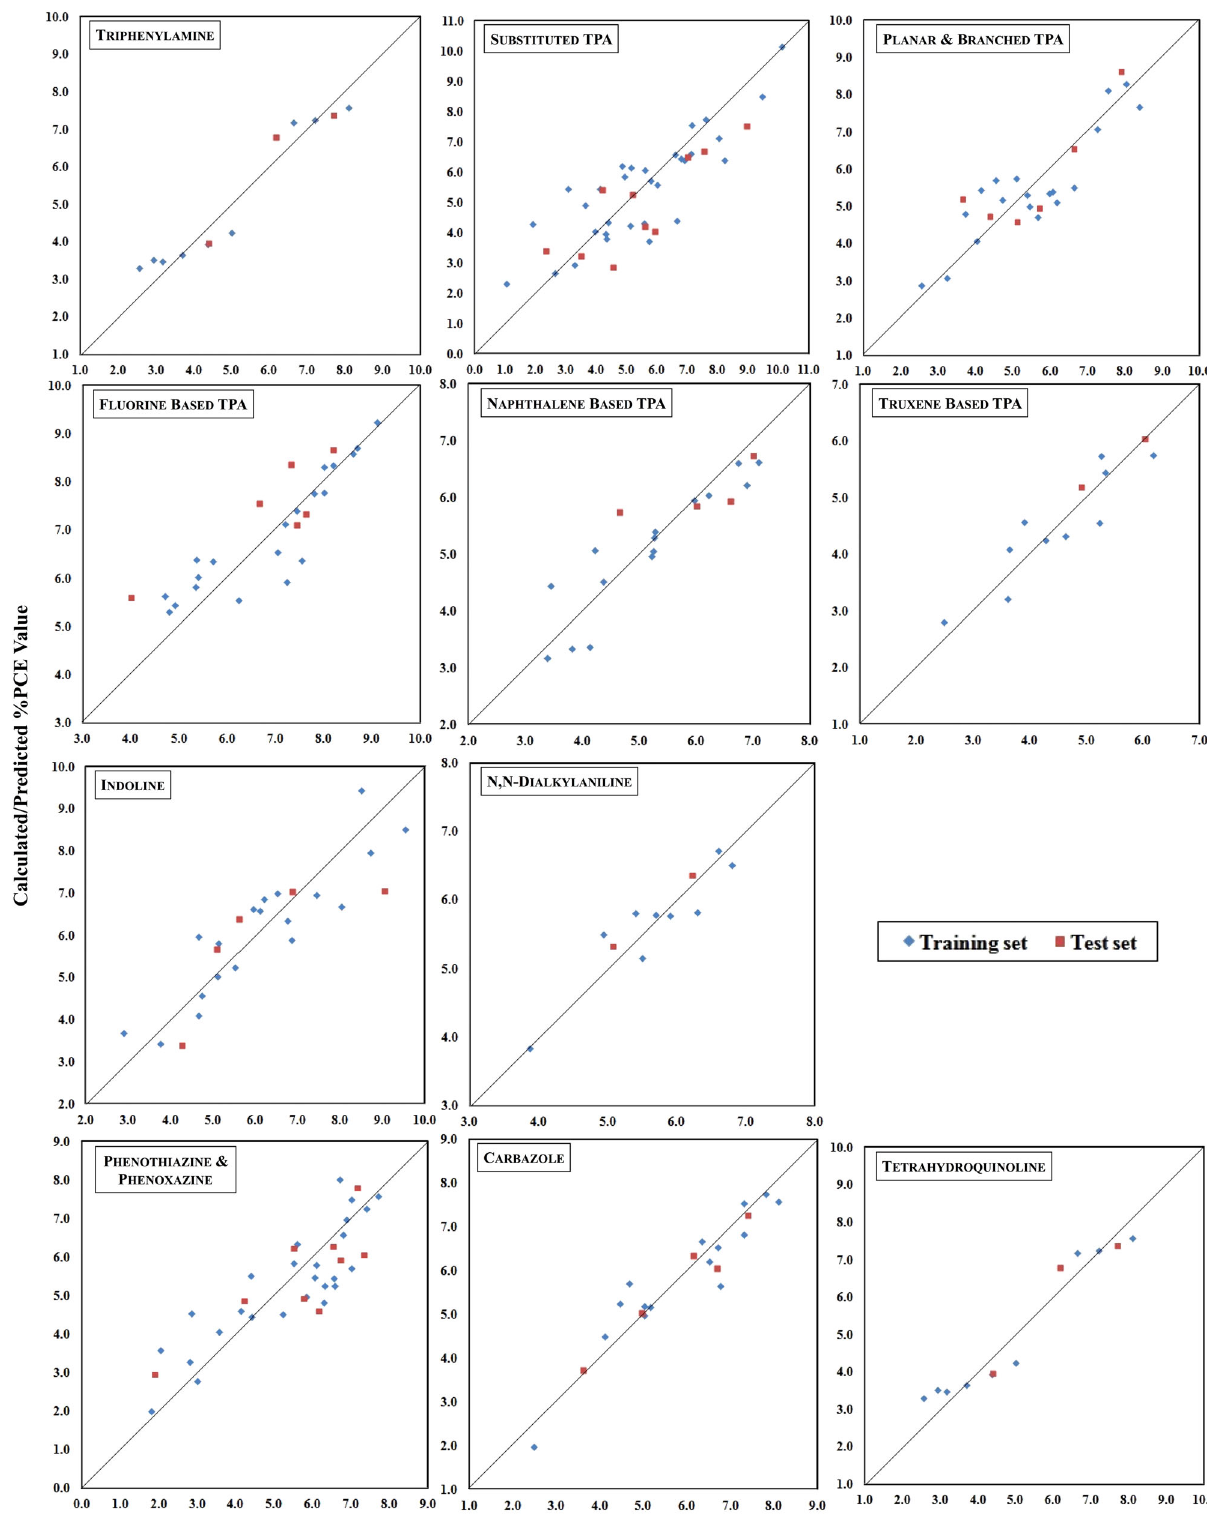
Fig. 1 Scatter plots of experimentally evaluated vs. predicted PCE values of AODs for all 11 chemical